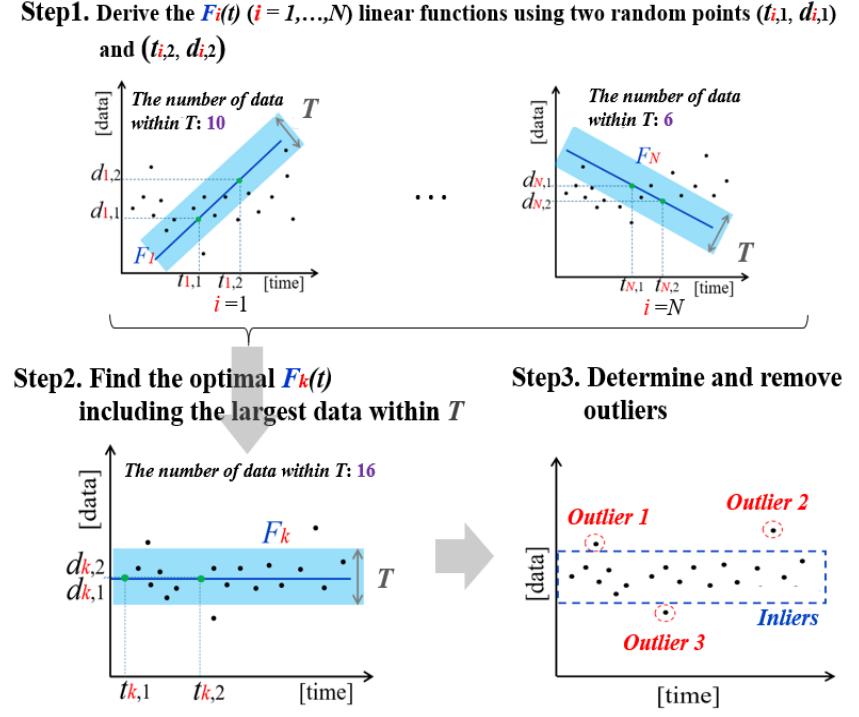
Figure 2. The RANSAC algorithm for detecting and removing outliers.